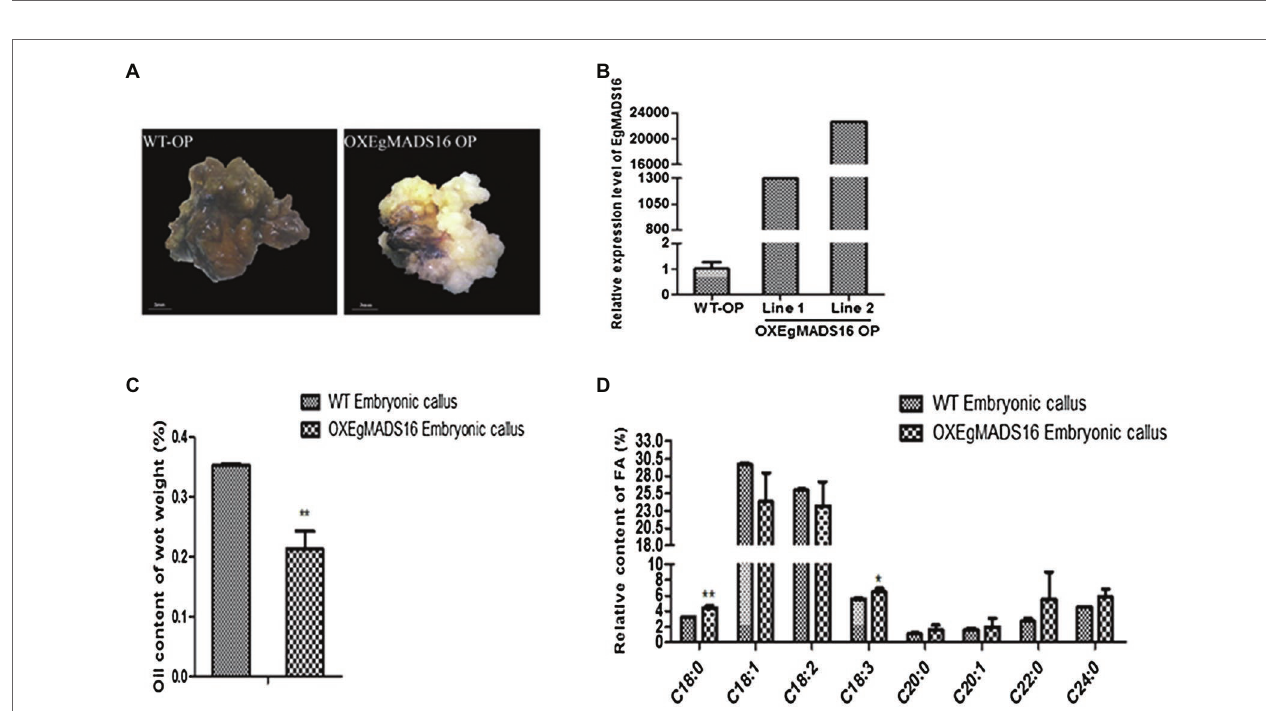
FIGURE 5 | Effect of EgMADS16 on lipid biosynthesis in Arabidopsis . (A) Wild-type Arabidopsis (WT-At) and EgMADS16 overexpression Arabidopsis (OXEgMADS16 At). (B) The relative expression level of EgMADS16 in WT-At and OXEgMADS16 At. (C) The oil content of WT and OXEgMADS16 Arabidopsis seeds. (D) The relative FA content of WT and OXEgMADS16 Arabidopsis seeds. The values are the means ± SD ( n = 3), “*” represents a significant difference ( p < 0.05), and “**” represents a highly significant difference ( p < 0.01) using Student’s t -test.